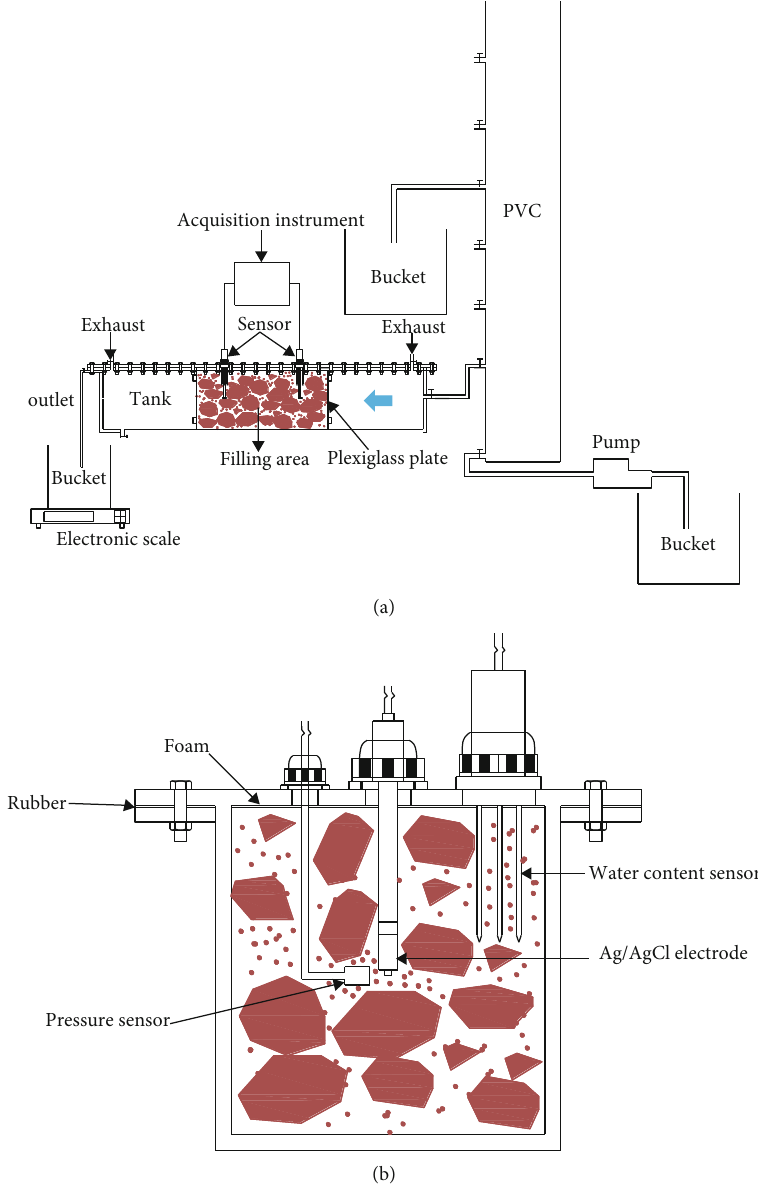
Figure 2: Sketch of the experimental apparatus. (a) The apparatus consists of a tank, PVC pipe, and data acquisition system. The blue arrow represents the direction of the water fl ow. (b) Cross section through the